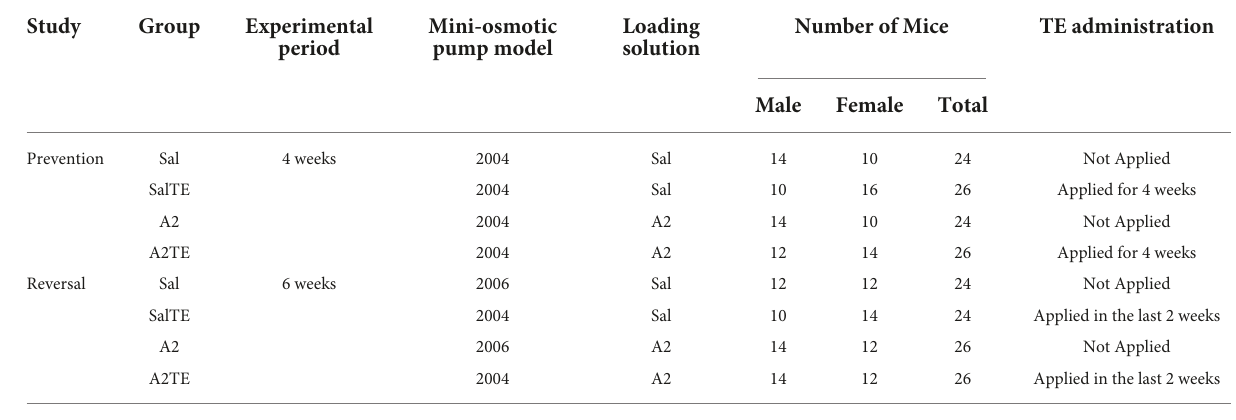
TABLE 1 Experimental